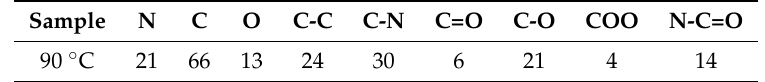
Table 4. Atomic composition (at%) and concentration (%) of chemical bonds for POx film deposited at substrate temperature of 90 ◦ C and at flow rate of 100